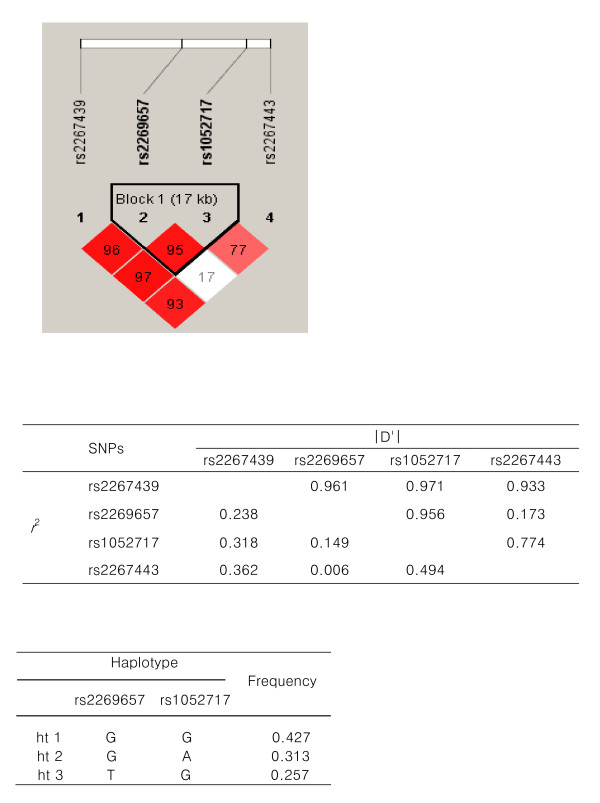
Linkage disequilibrium coefficients and haplotypes of SREBP-2 polymorphisms A. Linkage disequilibrium (LD) among SREBP-2 polymorphisms.B. LD coefficients (| D'| and r2) between SREBP-2 polymorphisms. C. Haplotypes and their frequencies between two linked SNPs, rs2269657 and rs1052717, in a LD block.